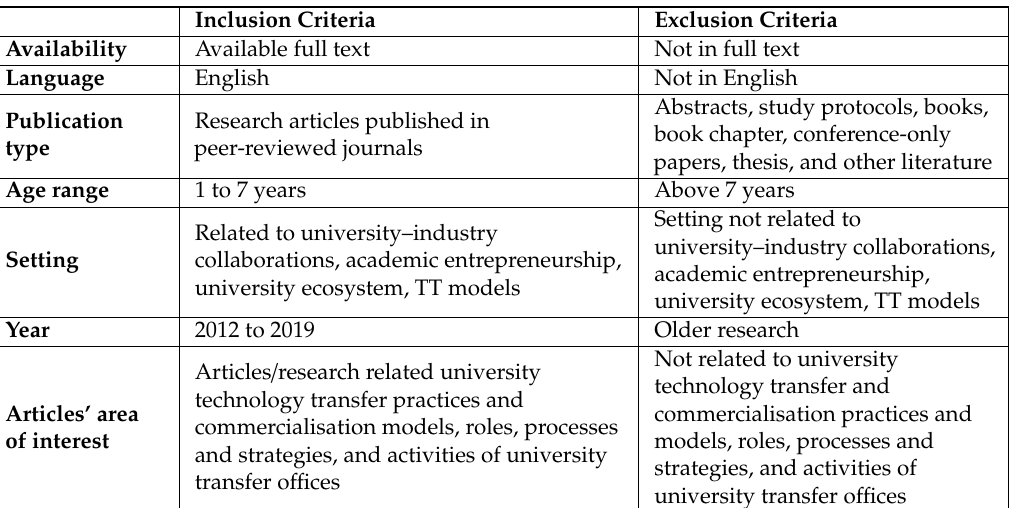
Table 1. Inclusion and exclusion